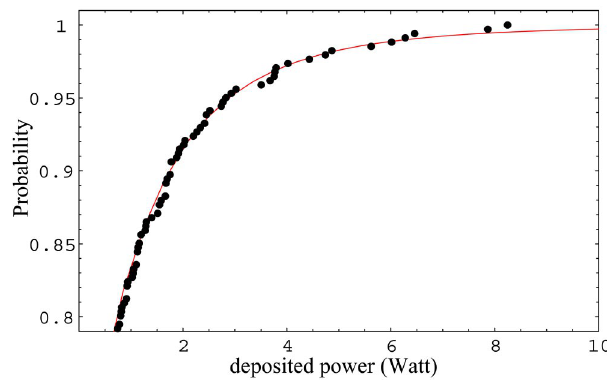
FIG. 21. (Color) Unnormalized probability density function for the losses at the first quadrupole of the first section. The deposited beam power (W) forms the abscissa and the number of counts the ordinate.